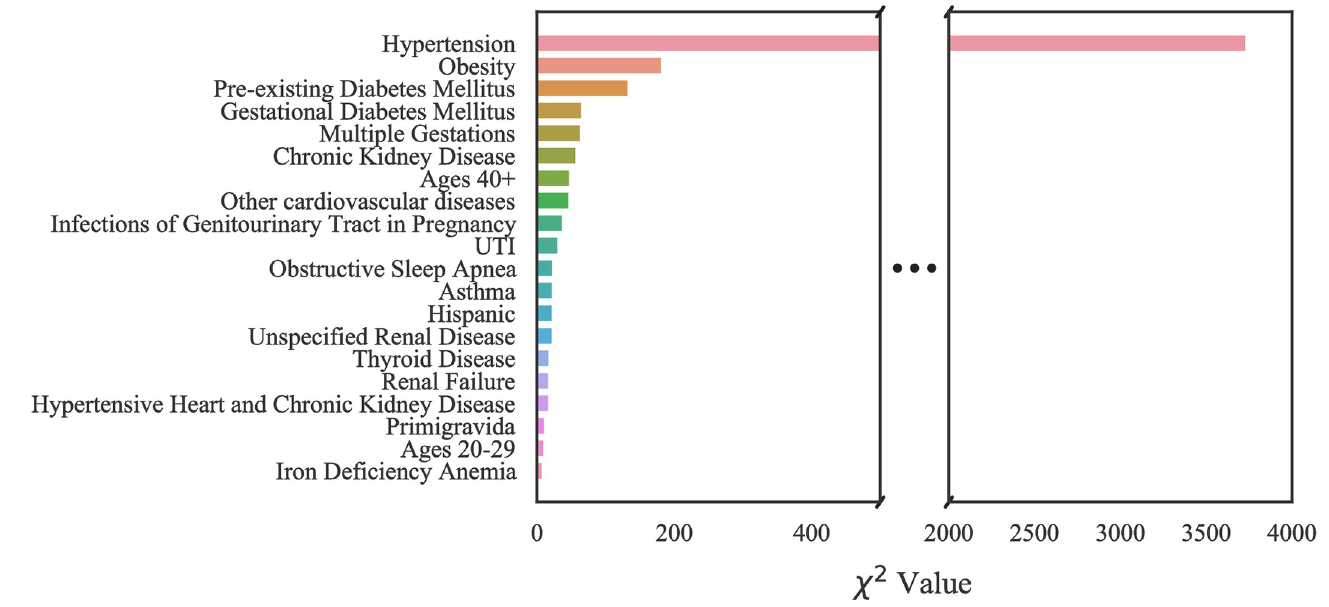
Fig 11. Feature ranking for the Texas African American